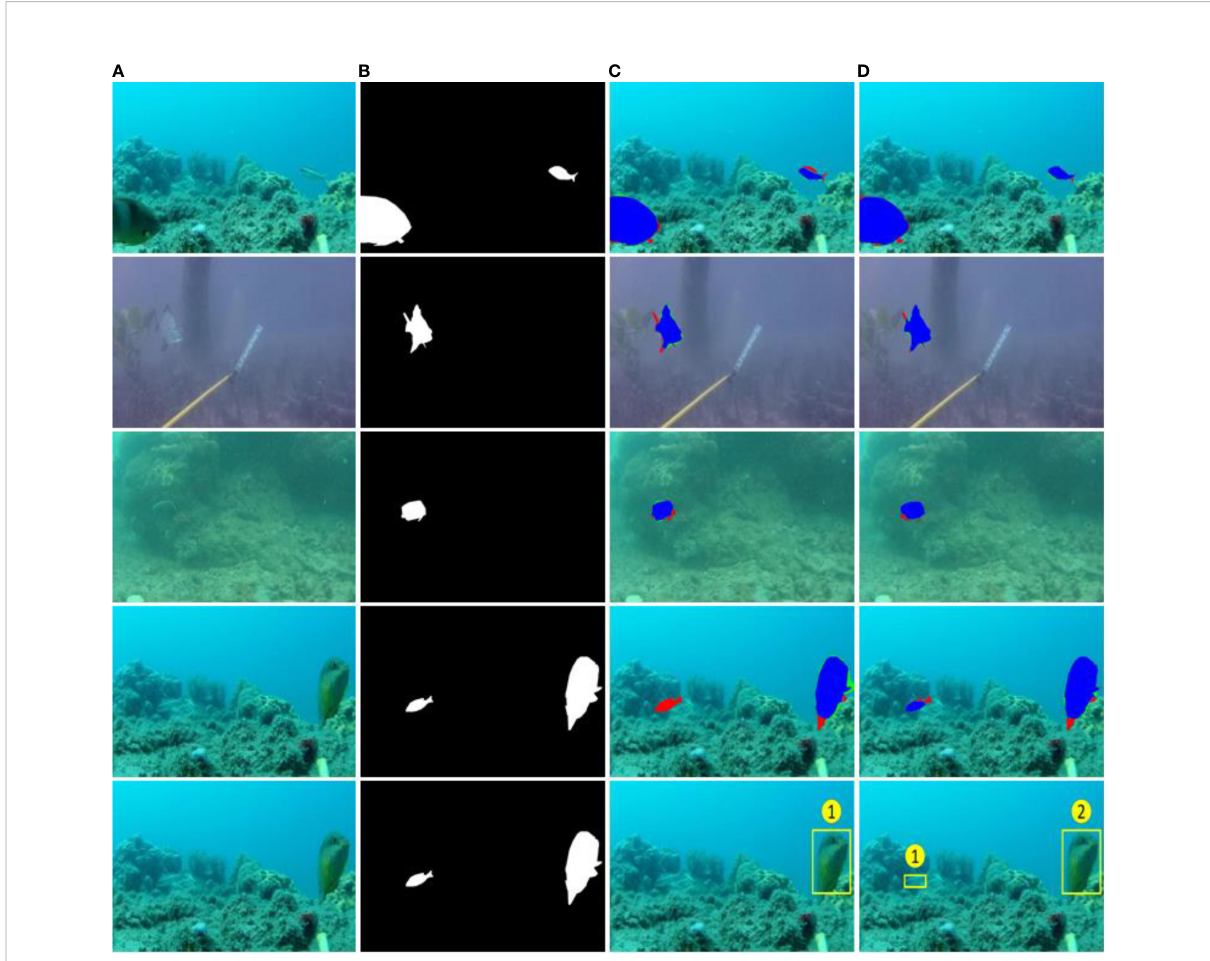
FIGURE 8 Good qualitative results by EFS-Net and MFAS-Net on the DeepFish dataset. Rows 1-4: Segmentation results; (A) original test image, (B) ground truth image, (C) segmented images achieved by applying EFS-Net, and (D) segmented images achieved by MFAS-Net (the fp and tp pixels are referred by green and blue colors, respectively. Pixel representation for fn is done with red color). Row 5: segmentation-based fi sh detection and